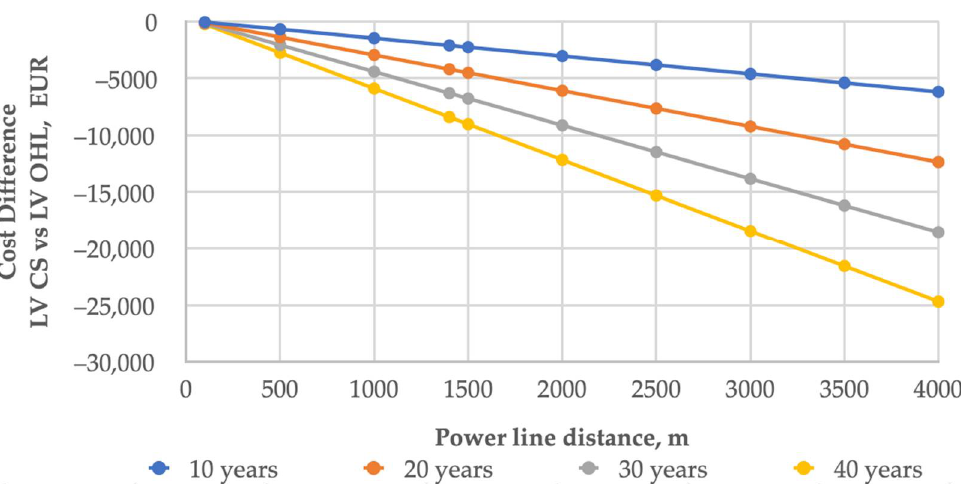
Figure 3. Difference between the total costs of the LV CS and the LV OHL (positive cost if LV OHL is more feasible, negative cost if LV CS is more feasible).